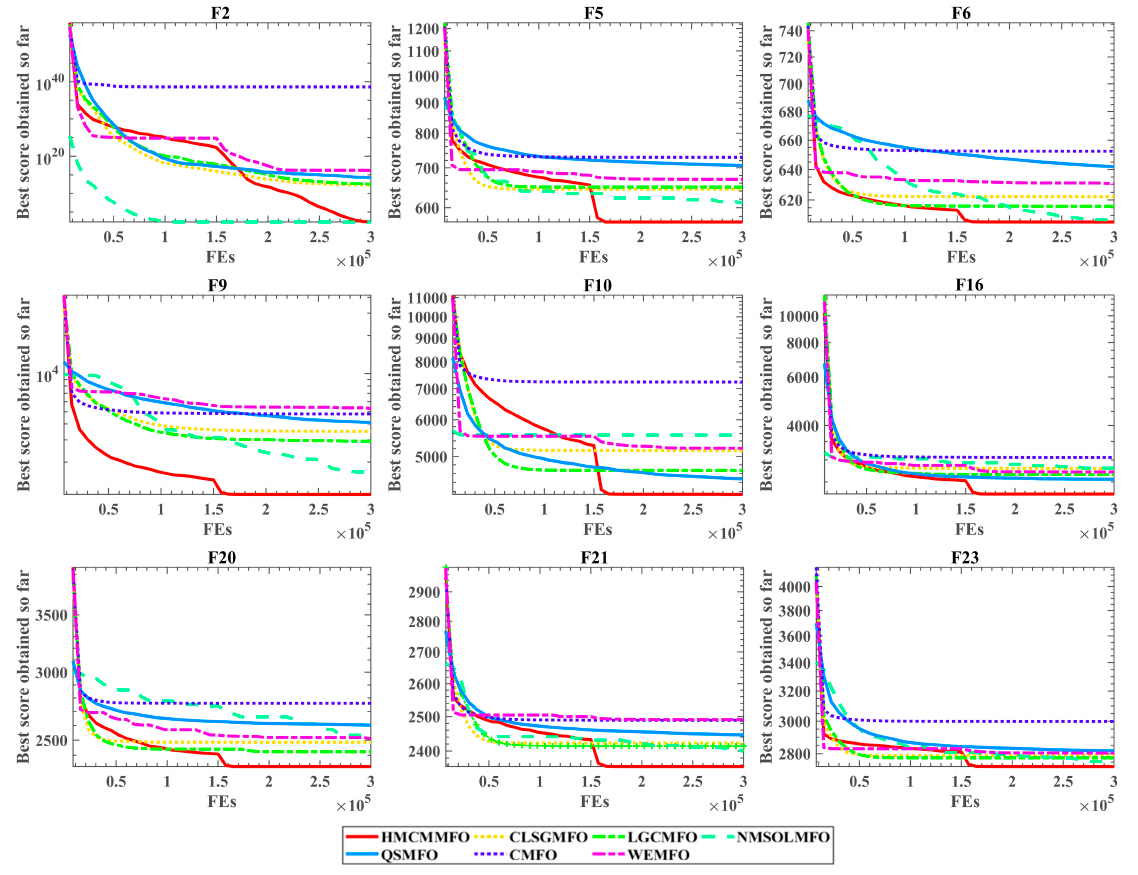
Figure 4. Convergence plots of the MFO variants.